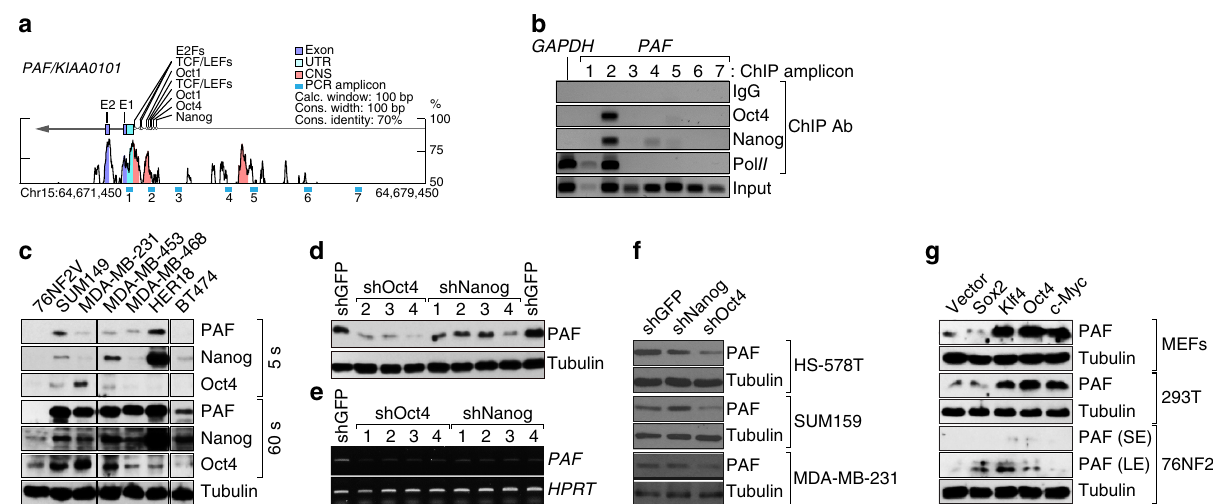
Figure 5 | PAF transactivation by Oct4 and Nanog. ( a ) PAF promoter analysis using VISTA genome browser. CNS, conserved non-coding sequence; TBE, TCF-binding elements; UTR, untranslated region. Green bars, PCR amplicons (1 B 7). ( b ) Oct4 and Nanog occupy PAF ’s proximal promoter. ChIP analysis of HER18. GAPDH promoter, a negative control for occupancy of Oct4 and Nanog; IgG, a negative control for IP; Input, 10% were used for ChIP–PCR; RNA polymerase II (Pol II), a positive control for ChIP. ( c ) Expression analysis of PAF, Oct4 and Nanog. IB assays. LE, long exposure; SE, short exposure. ( d – f ) Depletion of either Oct4 or Nanog downregulates PAF expression. HER18 cells stably expressing short hairpin RNAs (shRNAs) were analysed for IB ( d ) and semi-quantitative RT–PCR ( e ). Other breast cancer cell lines were stably transduced with lentiviruses encoding shRNAs against Oct4 or Nanog. PAF expression was analysed by IB. ( g ) Ectopic expression of stemness-associated factors upregulates PAF expression. Each cell line was transfected